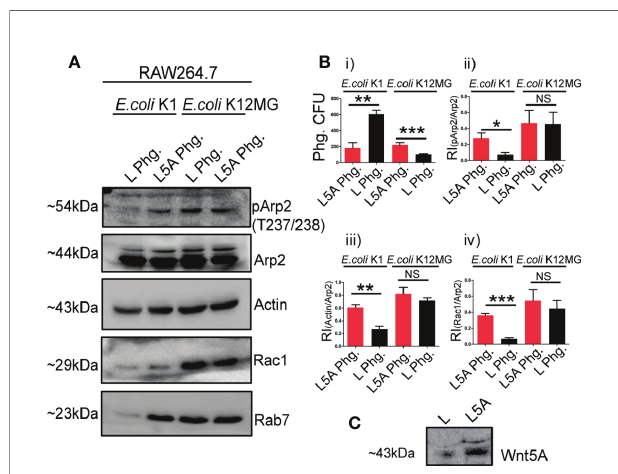
FIGURE 3 | Wnt5A (L5A) signaling aided actin assembly during pathogen vs. non-pathogen infection relates to altered phagosomal composition. Levels of phosphorylated Arp2 (pArp2), Actin, Rac1 and Rab7 with reference to unphosphorylated Arp2 was higher in phagosome of L5A treated E. coli K1 infected RAW264.7 macrophages (L5A Phg) 3 h post infection in comparison with the control phagosome from L treated infected RAW264.7 (L Phg.) as demonstrated by immunoblotting ( A : lanes 1, 2) (n = 3). In E. coli K12- MG1655 infection there was no such difference in the level of pArp2, Actin, Rac1, Rab7 between L5A Phg. and L Phg. ( A : lanes 3, 4). CFU enumeration demonstrated L5A mediated killing of K1 but not K12-MG1655 at phagosome level (B .i ) (n = 3). Bii, Biii and Biv depict the Relative Intensity (RI) of pArp2, Actin and Rac1 in relation to unphosphorylated Arp2 in L5A Phg. and L Phg of the E. coli K1 and E. coli K12-MG1655 infected sets. (C) depicts the presence of Wnt5A in L5A conditioned media (L-cells